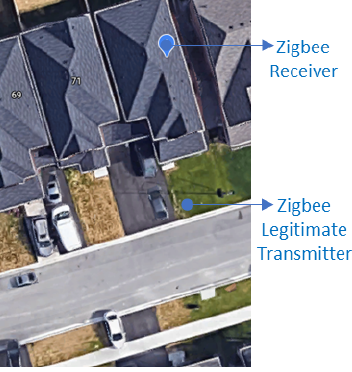
Figure 5. The legitimate transmitter is situated in the first floor family room while the legitimate receiver is situated in the second floor’s bedroom separated by interior walls and an interior floor. The 5 occupants in the property are considered to be the influencing moving objects.